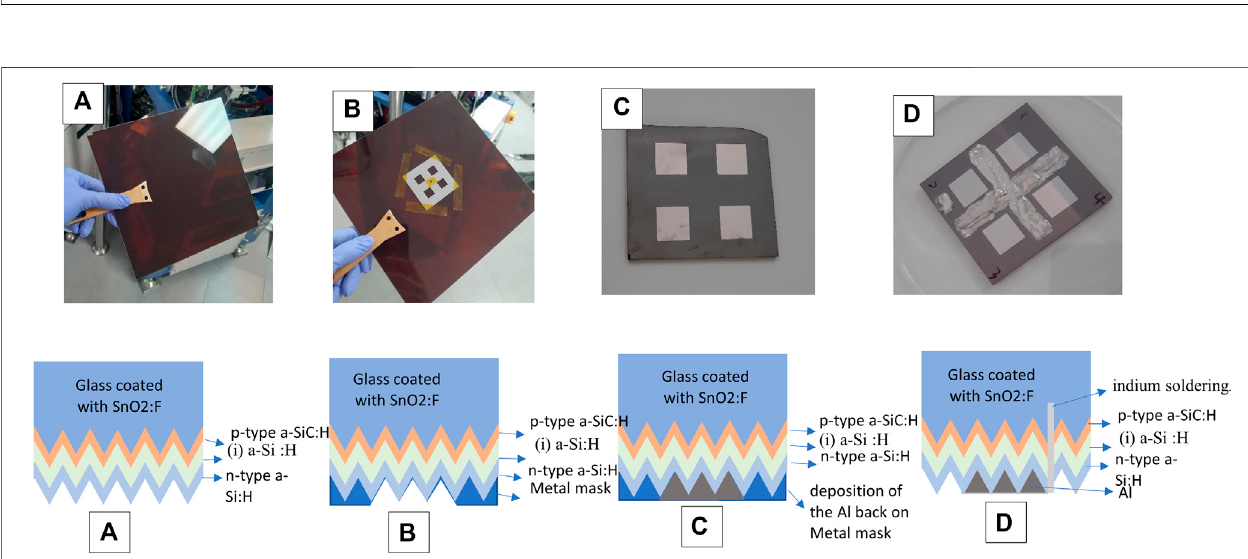
Frontiers in Mechanical Engineering |